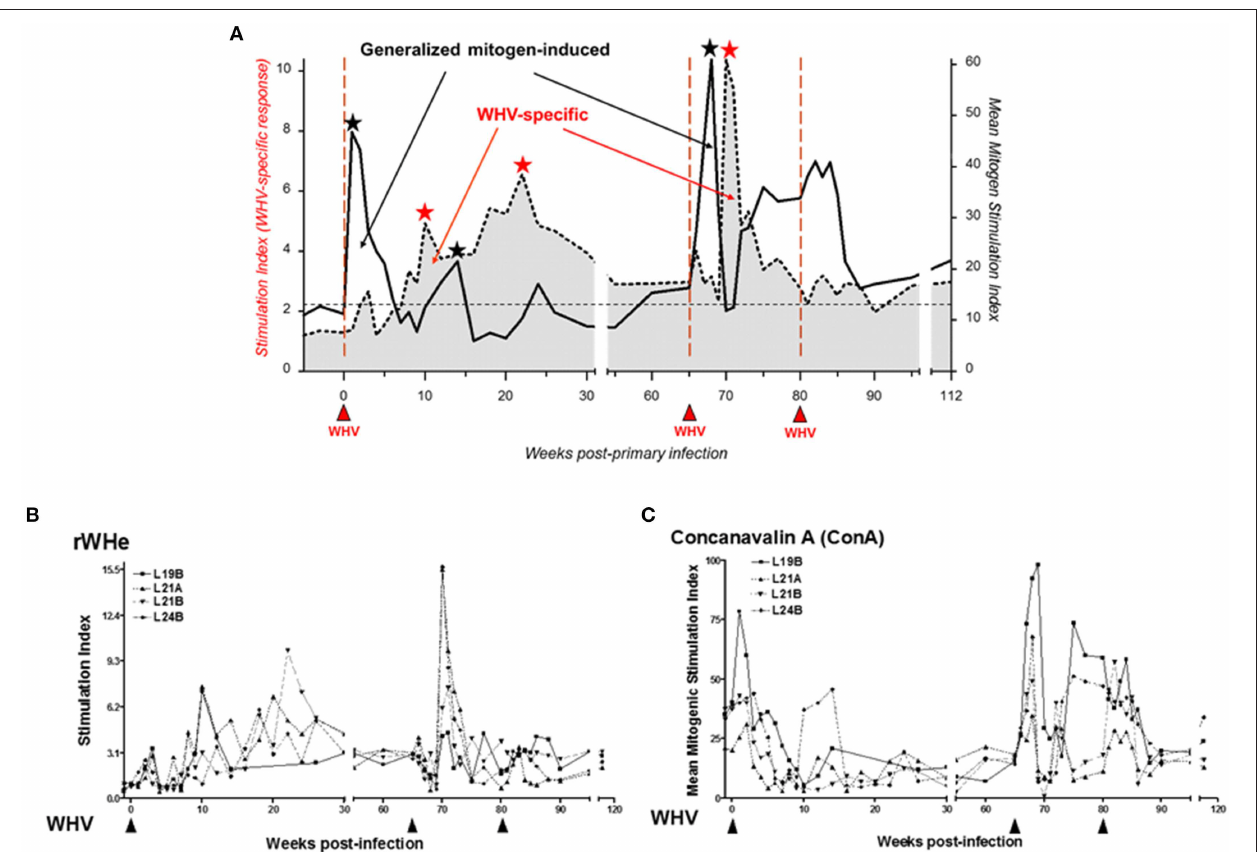
FIGURE 4 | Distinct kinetics of WHV-specific and generalized T cell proliferative response following infection with a liver pathogenic dose of WHV and subsequent challenge with the same ioclum. (A) Schematic depiction of the cumulative data on discordance between virus-specific and generalized, mitogen-induced T cell proliferative responses. The profiles were compiled based on the data obtained from 4 animals with self-limited acute hepatitis after infection with 1.9 × 10 11 DNase digestion-protected WHV virions using a flow cytometry CFSE assay to assess T cell proliferation in response to five different recombinant or native WHV proteins and WHc 97 − 110 peptide (stimulation index values, SI) and in response to five 2-fold dilutions of mitogen concanavalin A (ConA) ranging from 1.25 to 20 µ g/mL measured by a [ 3 H]-adenine incorporation assay (mean mitogen stimulation index values, MMSI). The mean of the highest SI given by any WHV antigen or that of MMSI in response to any ConA concentration from each of four animals were used to construct the profiles. Solid red upward arrowheads indicate injections with WHV. Black and red stars mark peaks of mitogen-induced and WHV-specific T cell responses, respectively. The data demonstrate that WHV first triggers polyclonal generalized activation of T cells and then WHV-specific T cell response. (B) An example of the WHV-specific T cell response to recombinant WHV e protein (rWHe) in the same 4 animals shown in panel A. (C) An example of the mitogen-induced T cell proliferation after infection and challenge with WHV in response to stimulation with ConA. Figures adopted with modifications from Gujar et al.